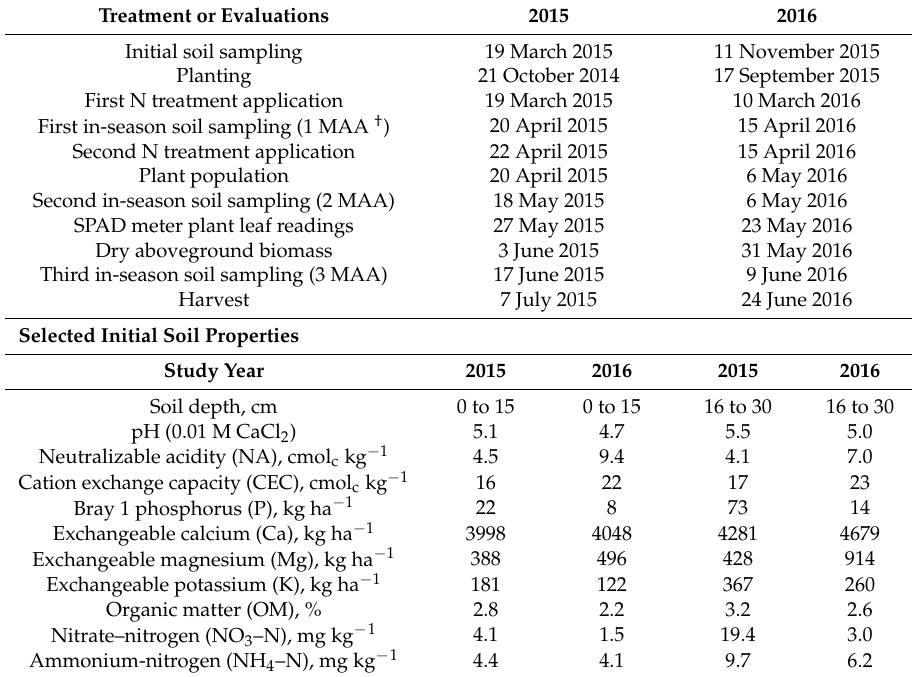
Table 1. Treatment, evaluation dates, and selected soil initial properties in 2015 and